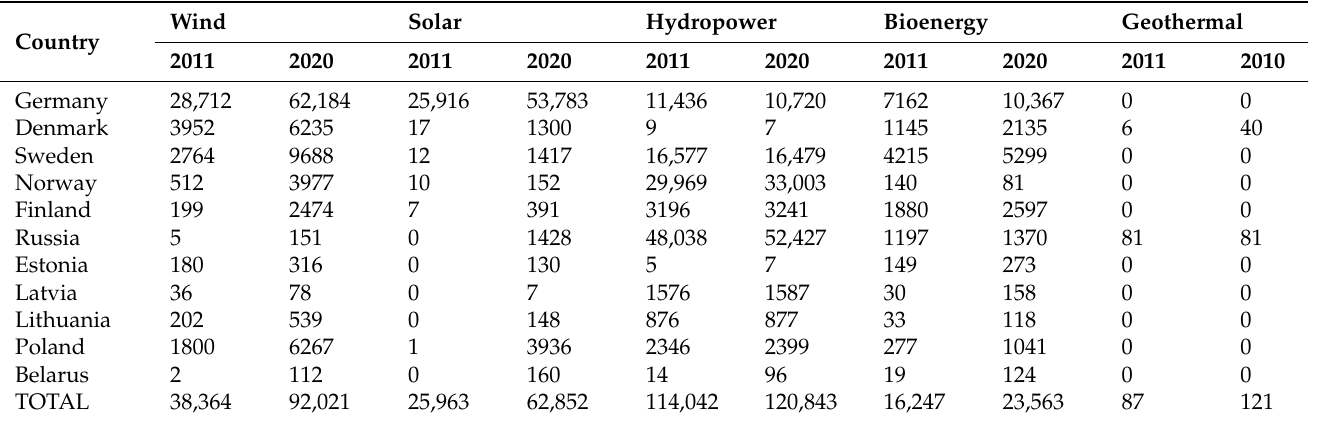
Figure 6. Energy efficiency and renewable energy use in BSR in 2014. Source: own study based [44]. The use of particular types of energy in BSR states is diversified (Table 1). Renewable power generation capacity is measured as the maximum net generating capacity of power plants and other installations that use renewable energy sources to produce electricity [45]. Table 1. Renewable energy capacity in BSR states in 2011 and 2020 (MW).